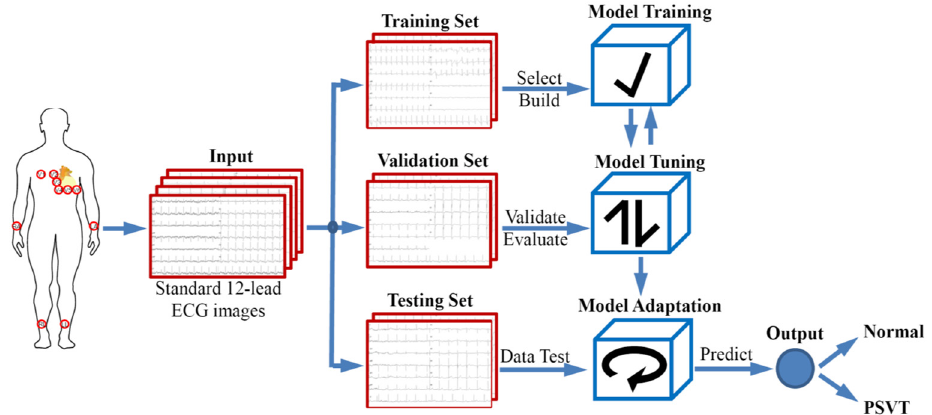
Figure 2. The comprehensive process of the creation and evaluation of the CNN model. The ECG images were acquired and allocated to the training set, validation set, or testing set. ECG images in the training set were used as the input of the CNN, whereas the testing set was used to evaluate the screening performance of the CNN model.